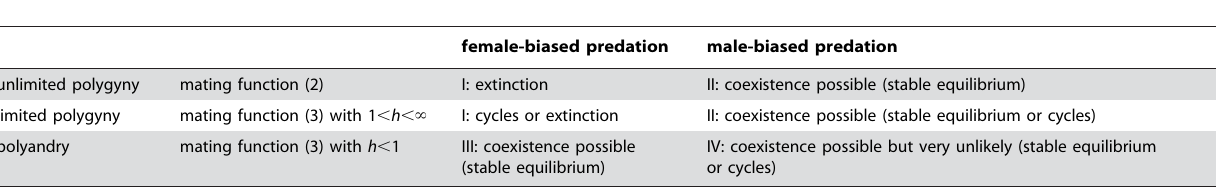
Table 1. Summary of the dynamics of the predator-prey system